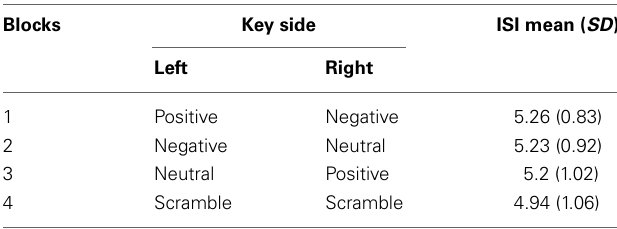
Table 2 | Key-category coupling and inter-stimulus-interval (ISI) in the four experimental